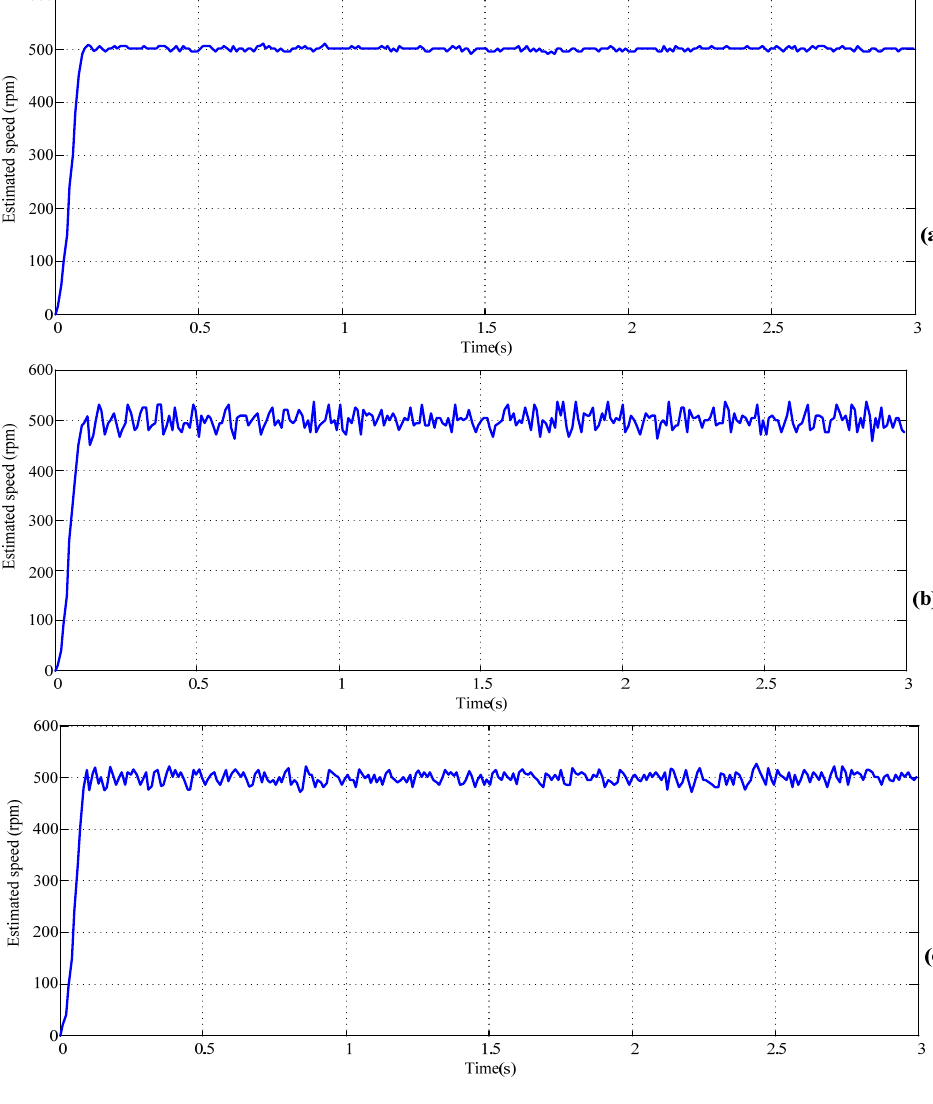
Figure 13. The step speed responses of 500 rpm without loading by (a) encoder, (b) ISMO, and (c) NN-ISMO, respectively.